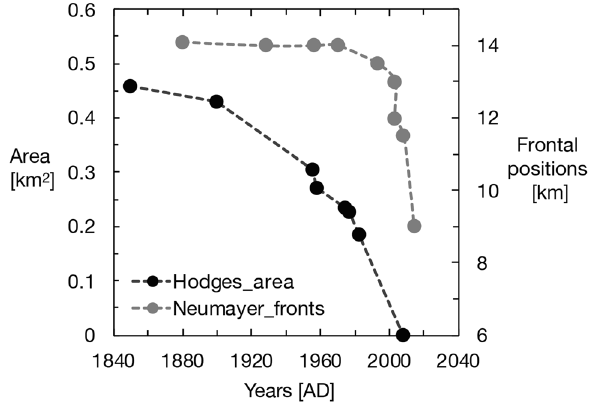
Figure 3. The modern retreat pattern of Hodges Glacier (primary y-axis, change measured in km 2 ) in West Cumberland Bay and the larger Neumayer tidewater glacier (secondary y-axis, change measured in km extent) in East Cumberland Bay since 1850 AD. The glacier retreat patterns reveal an accelerated recession since the 1970s. The Hodges glaciers had disappeared by 2008, as observed by the authors. Neumayer is soon to become land-locked (the data for this figure are from papers 2,3,21 and from AGU Blogshpere (https:// blogs. agu. org/ froma glaci erspe rspec tive/ categ ory/ south- georg ia- glaci er- retre